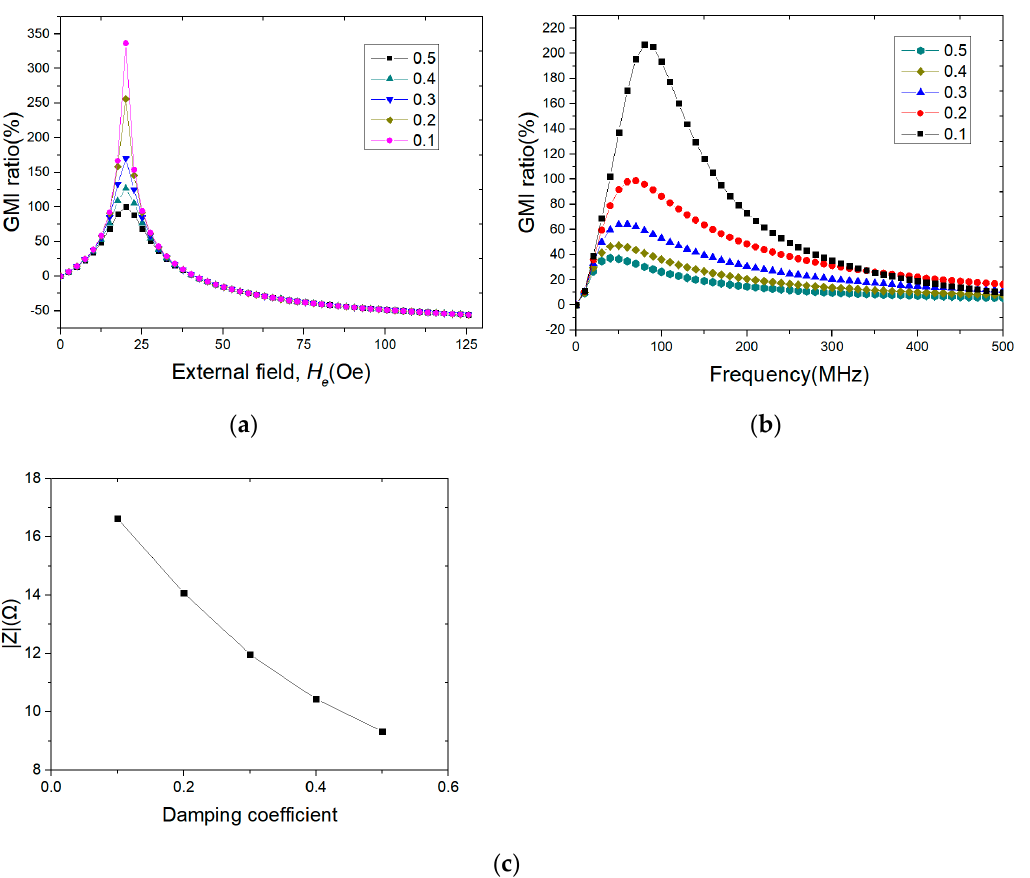
Figure 4. Effect of damping coefficient on GMI effect in cylindrical alloy fiber. ( a ) Curve of GMI effect with external field. ( b ) Curve of GMI Effect with frequency. ( c ) Curve of impedance value with damping coefficient.